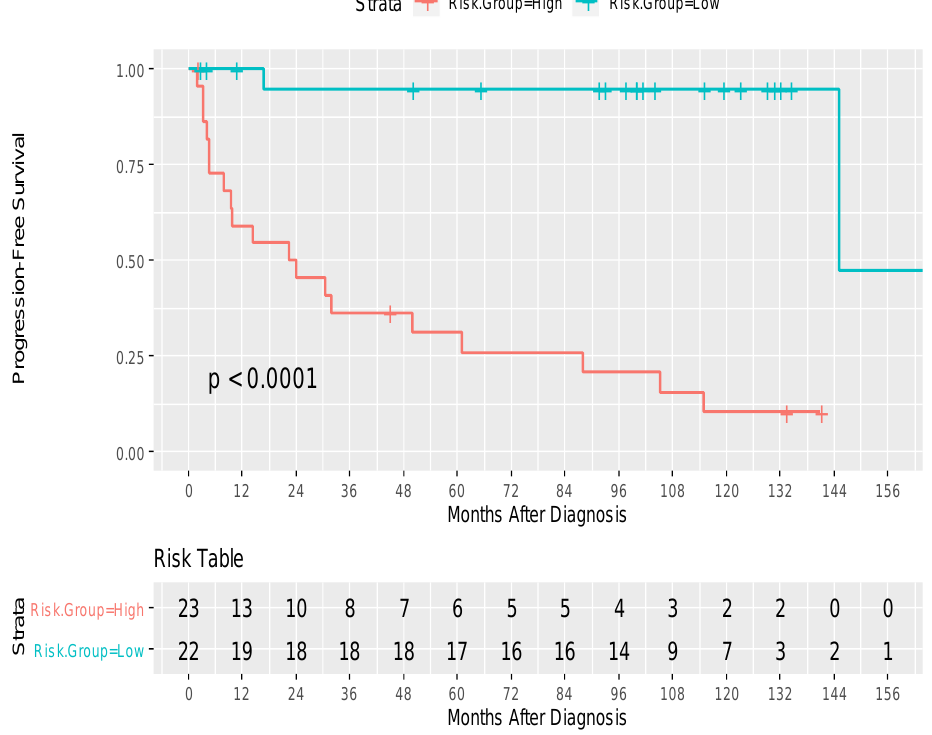
Figure 2. Kaplan–Meier curves of recurrence-free survival amongst patients with High- and Low-risk groups. The risk score was calculated for each patient. The scores from high to low were ranked and split at the median; the ½ of patient with higher scores were labeled the “high risk group”. The high- and low-risk groups were compared, and P-value was calculated by log-rank test.